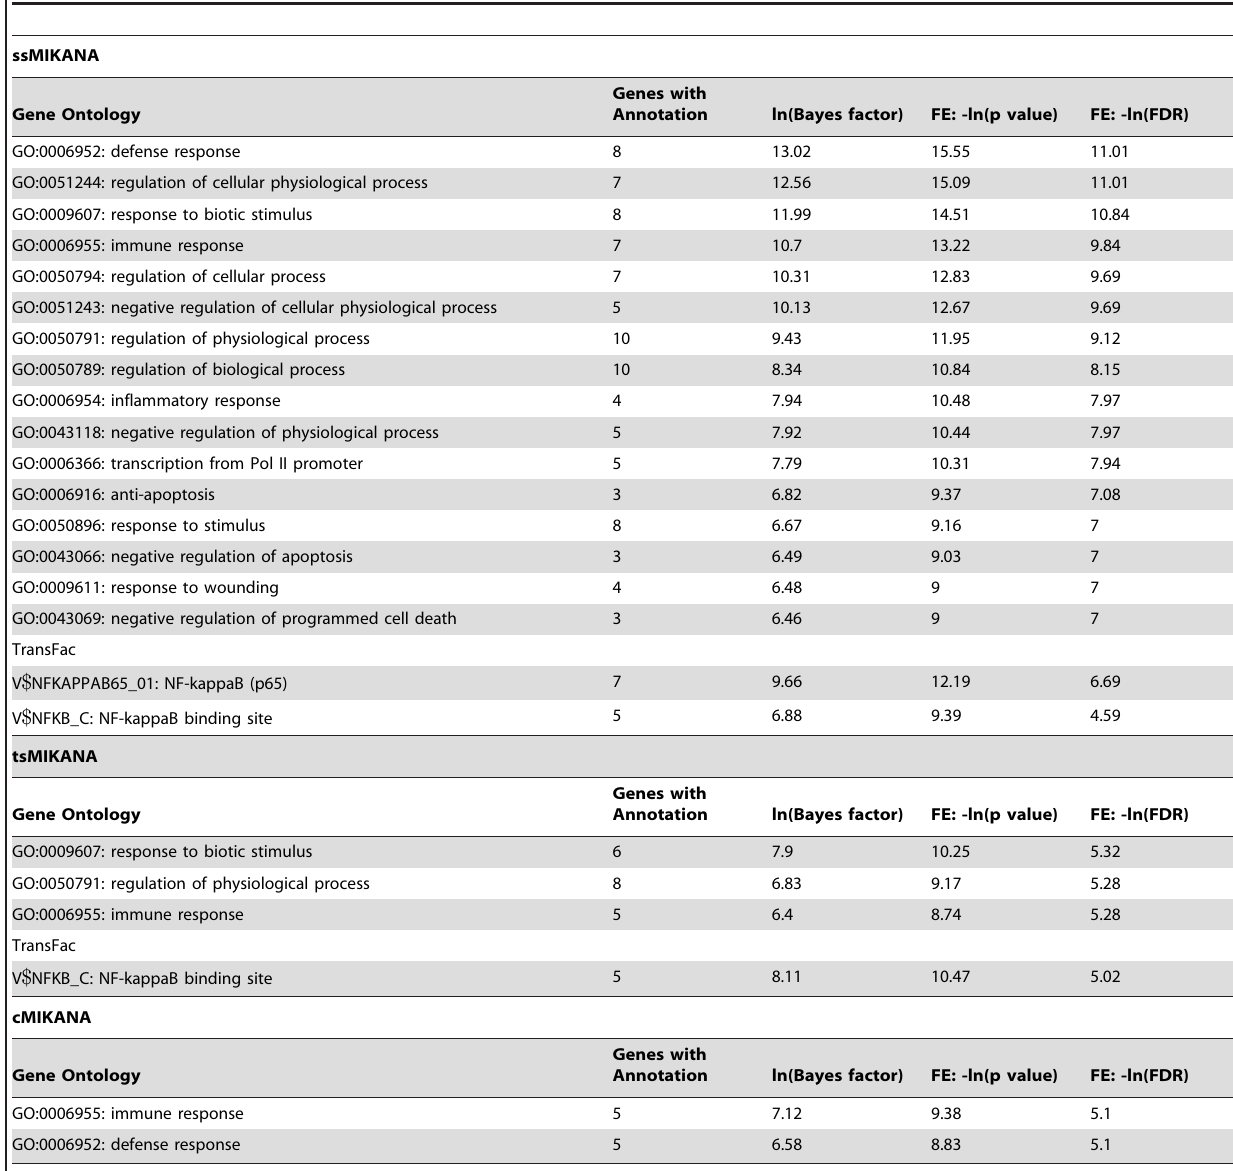
Table 3. Biological enrichment analysis for the top 10 hubs in the ssMIKANA, tsMIKANA and cMIKANA network models.